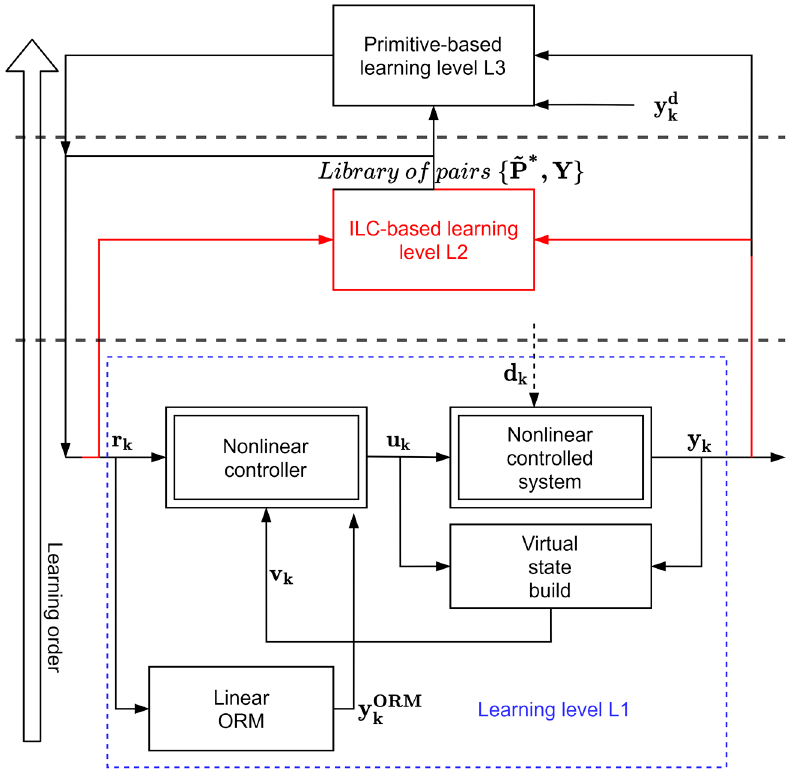
Figure 3. The hierarchical learning on levels L1–L3. Possible disturbances d k may affect the nonlinear controlled system.